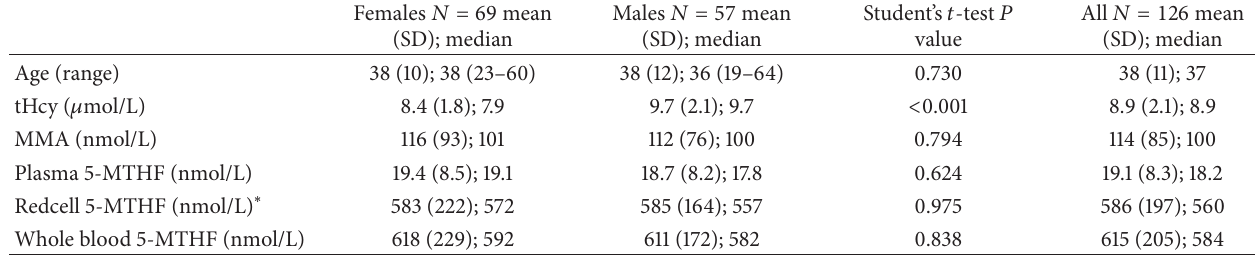
Table 1: Summary of results of 𝑁 = 126 subjects used to derive 5-MTHF reference intervals.